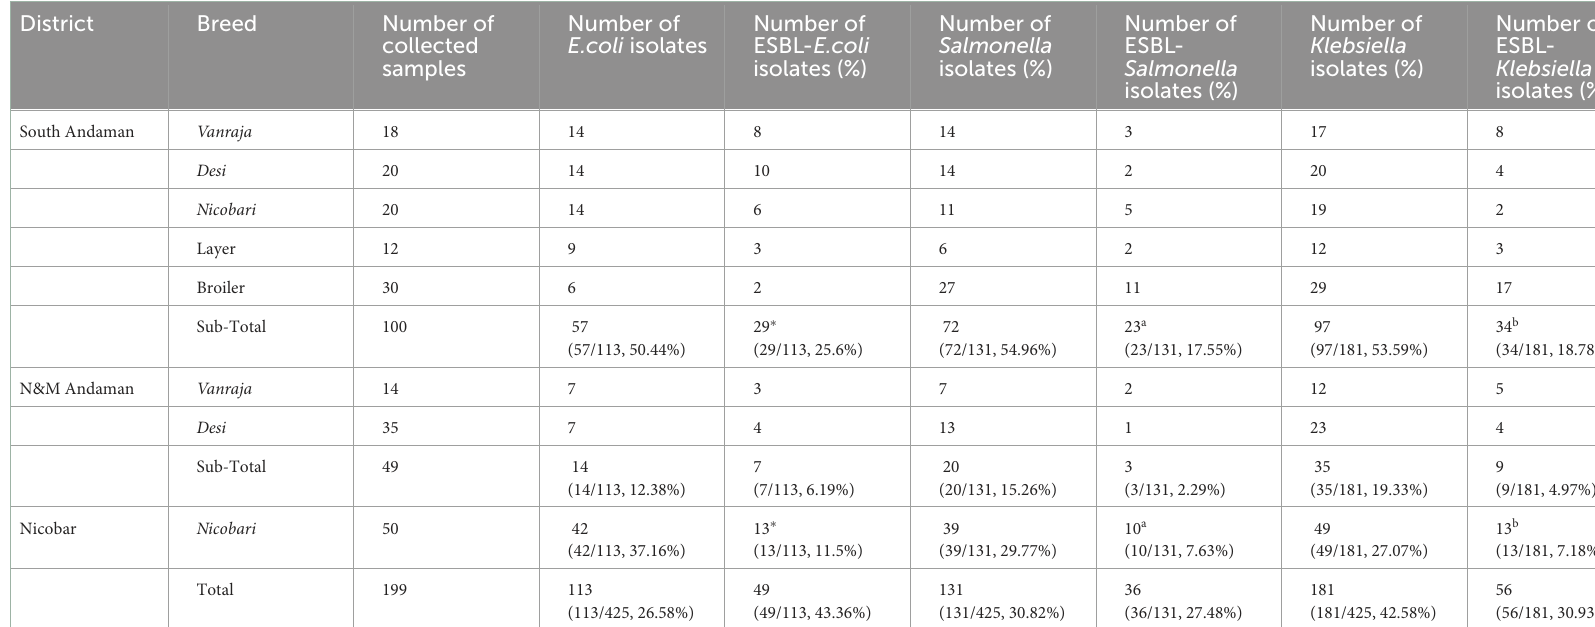
TABLE 1 Distribution of ESBL-producing E. coli , Salmonella , and Klebsiella in three districts of Andaman and Nicobar Islands (India). District Breed Number of